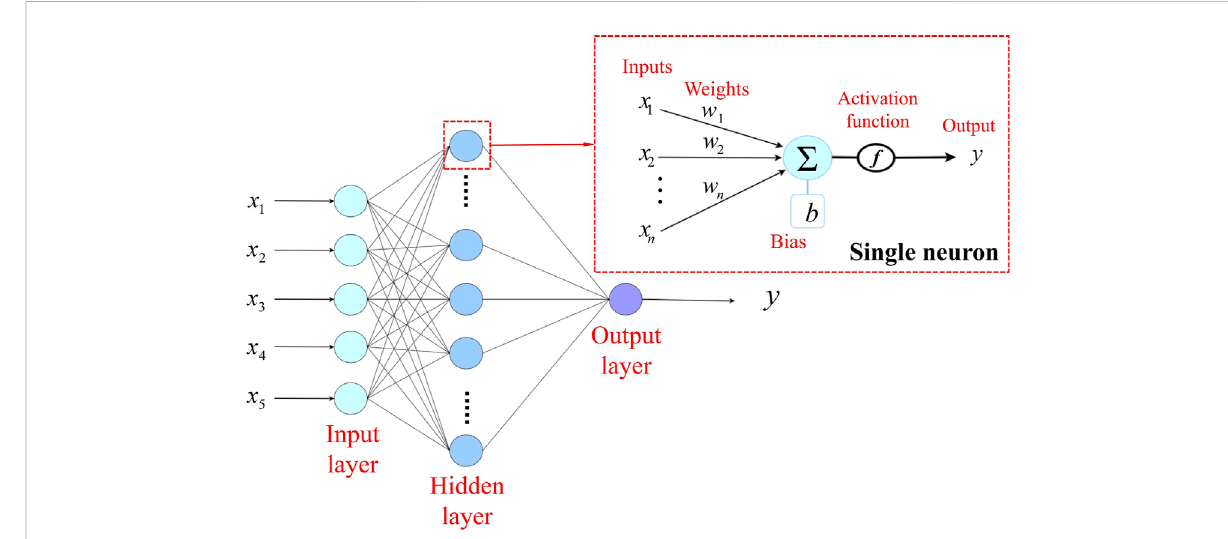
FIGURE 2 Single hidden layer neural network.